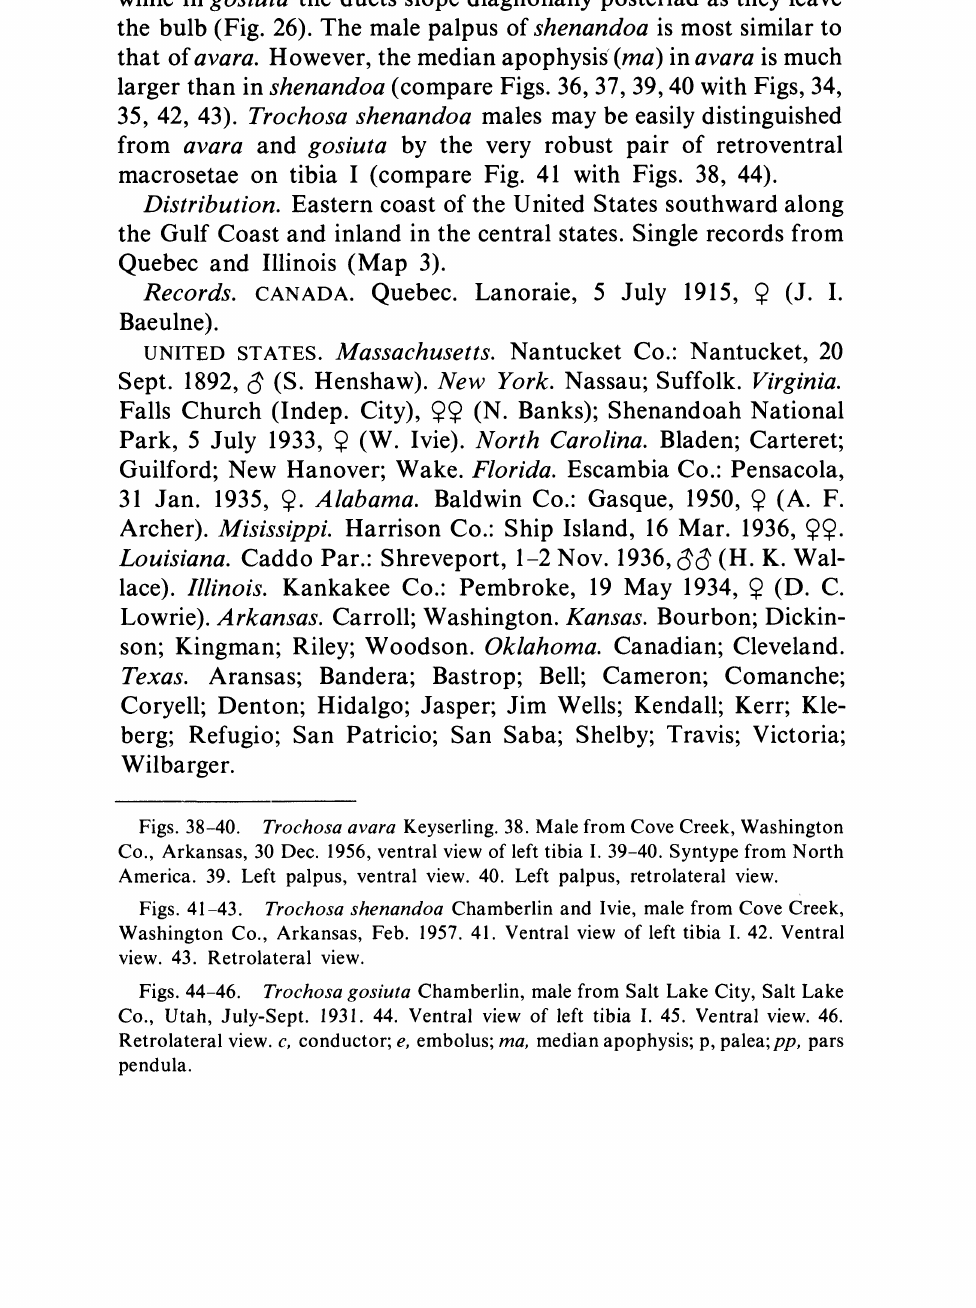
Figs. 38-40. Trochosa avara Keyserling. 38. Male from Cove Creek, Washington Co., Arkansas, 30 Dec. 1956, ventral view of left tibia I. 39-40. Syntype from North America. 39. Left palpus, ventral view. 40. Left palpus, retrolateral view. Figs. 41-43. Trochosa shenandoa Chamberlin and Ivie, male from Cove Creek, Washington Co., Arkansas, Feb. 1957. 41. Ventral view of left tibia I. 42. Ventral view. 43. Retrolateral view. Figs. 44-46. Trochosa gosiuta Chamberlin, male from Salt Lake City, Salt Lake Co., Utah, July-Sept. 1931. 44. Ventral view of left tibia I. 45. Ventral view. 46. Retrolateral view. c, conductor; e, embolus; ma, median apophysis; p, palea;pp, pars